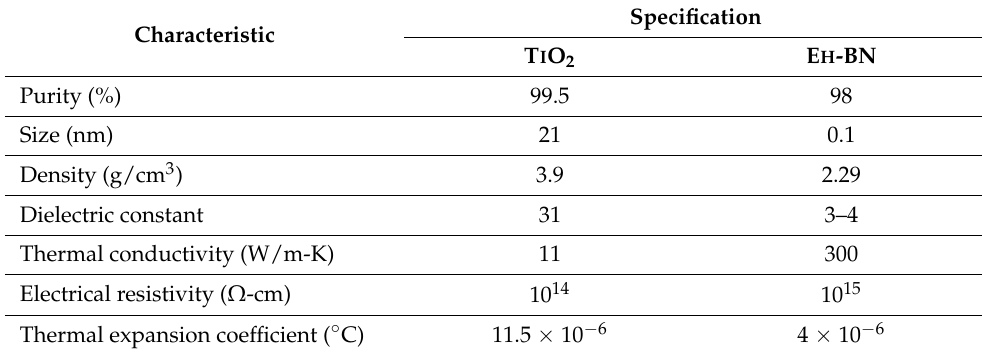
Table 2. Specifications of NP.